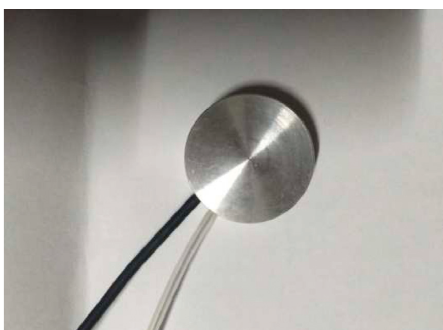
Figure 5: Soil pressure gauge.